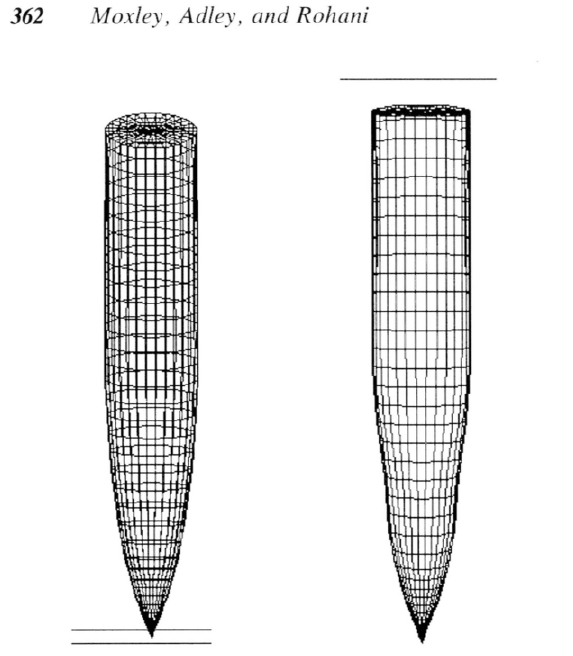
FIGURE 7 Undeformed and deformed shape at 0.60 ms after impact (scale factor = 2.0).